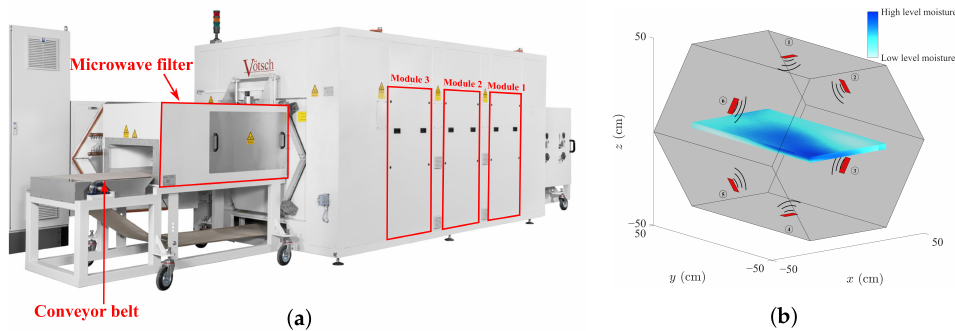
Figure 1. The microwave drying oven: ( a ) The HEPHAISTOS microwave system operating at KIT, Germany. ( b ) A schematic of one of the cavity modules with six microwave sources.